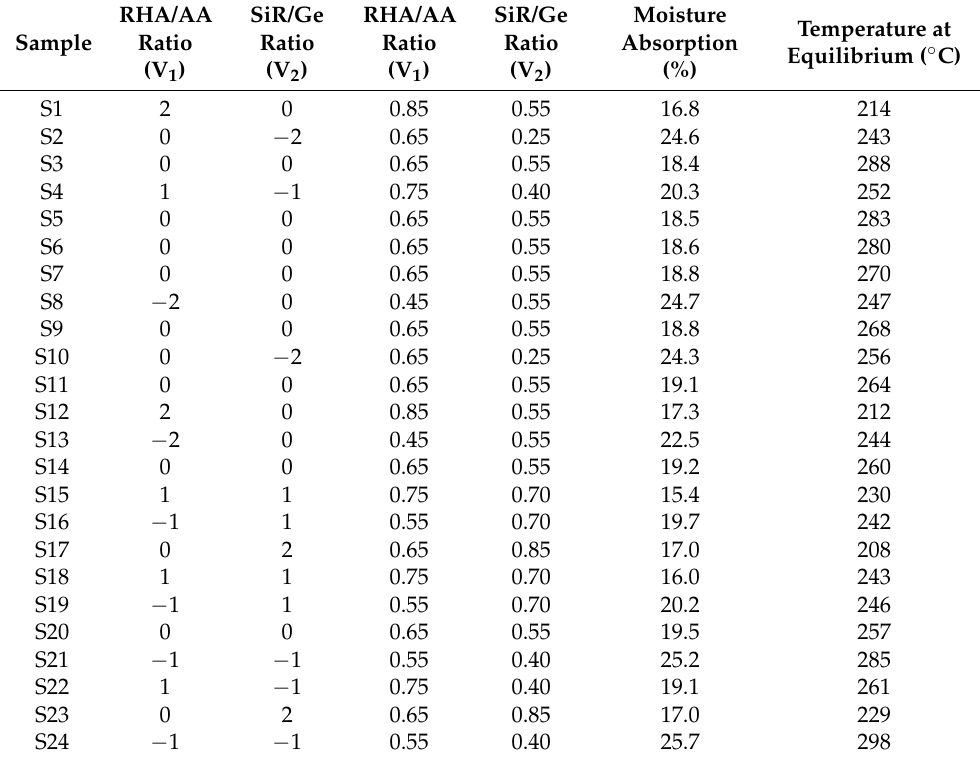
Table 5. Design matrix and response value for the temperature at equilibrium and moisture